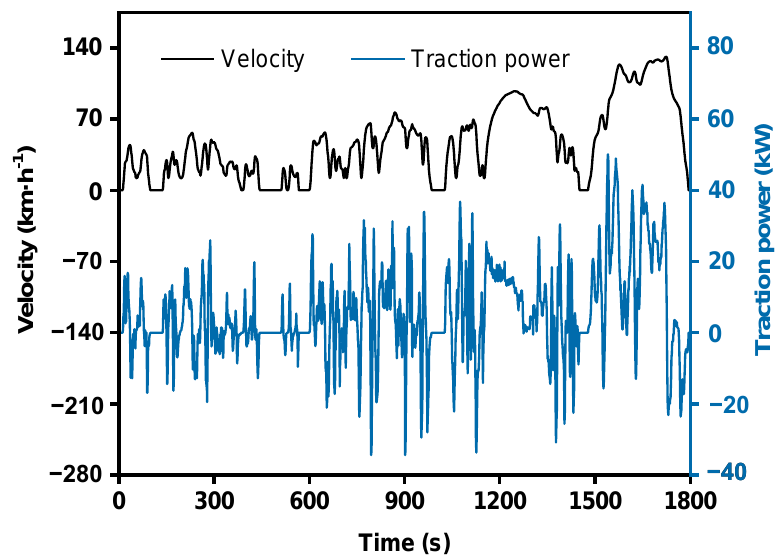
Figure 10. Velocity and traction power profiles of WLTC.